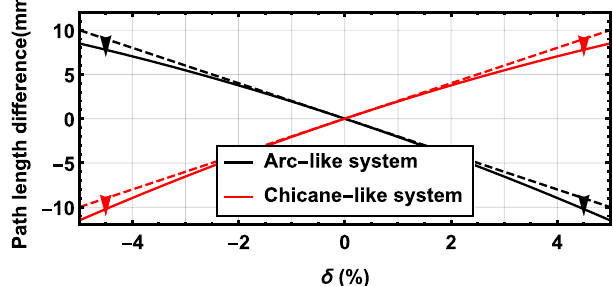
FIG. 1. Path length difference with respect to the design trajectory as a function of momentum deviation for uncorrected arclike (black) and chicanelike (red) compressors showing their respective deviations from linearity (dashed). R 56 ¼ − 0 . 2 m T . 6 m in the chicanelike system.